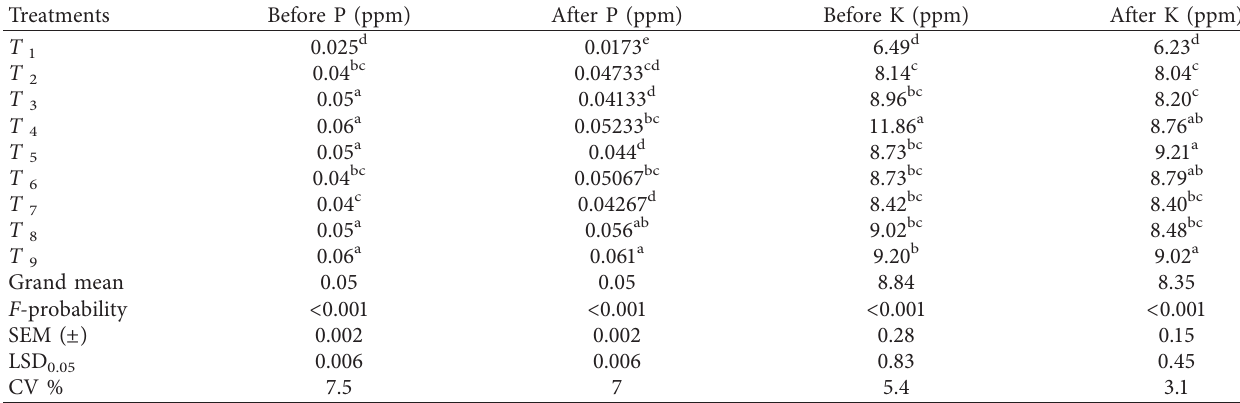
Table 6: Effect on soil potassium content before and after the wheat harvest.